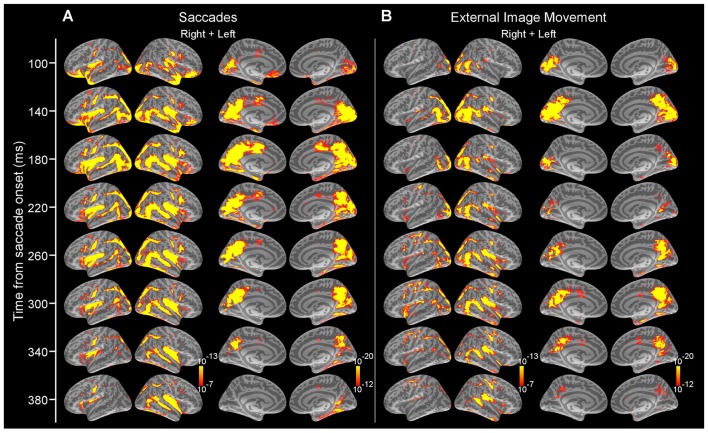
Average dSPMs following the onset of saccades in Experiment 1 and external image movement that mimicked saccades in Experiment 2. (A) Experiment 1. Snapshots of average dSPMs at selected latencies after saccade onset. (B) Experiment 2. Snapshots of average dSPMs at selected latencies after saccade-like external image motion. Saccades and saccade-like external visual stimulation produced early-latency responses beginning ~70 ms after onset in occipital cortex and spreading through the ventral and dorsal visual streams to temporal, parietal and frontal cortices. Average dSPMs are displayed on the inflated hemispheres of the average brain of all subjects (N = 7). Significance is indicated with color bars.